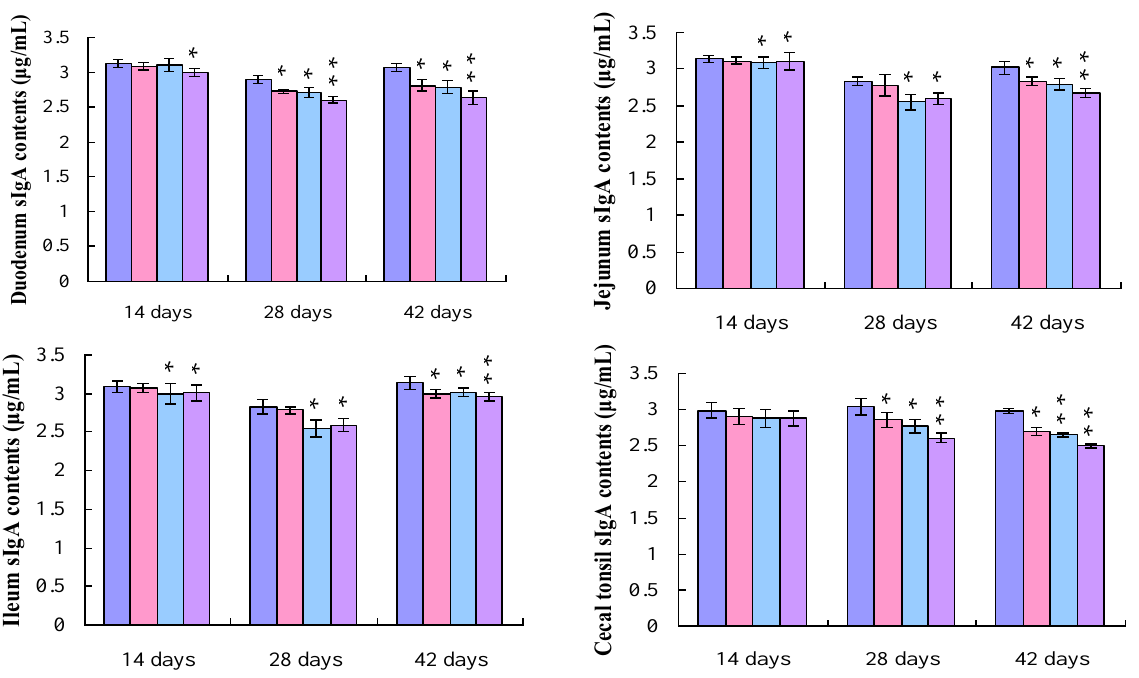
Figure 7. Change in the sIgA contents (μg/mL) in the intestinal mucosa and cecal tonsil in